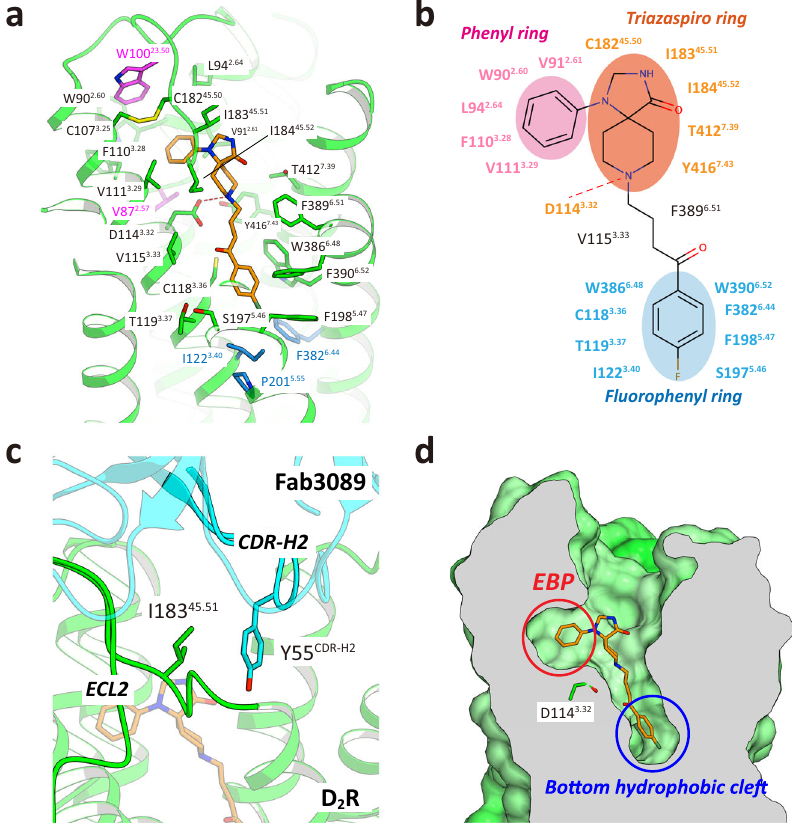
Fig. 2 The ligand-binding pocket of D 2 R spi . a Close-up view of the ligand-binding pocket of D 2 R spi . Spiperone and D 2 R are indicated in orange and green, respectively. The side chains of the contact residues within 4.5 Å of spiperone are shown as green sticks. The side chain of W100 23.50 is indicated in magenta. The side chains of the residues in the PIF motif are shown as blue sticks. b Diagram of the interactions between D 2 R and spiperone. c Fab3089 binding site. The side chains of I183 45.51 of D 2 R spi and Y55 of Fab3089 are shown as green and cyan sticks, respectively. d Vertical cross section of ( a ). Red and blue circles indicate the EBP and the bottom hydrophobic cleft,